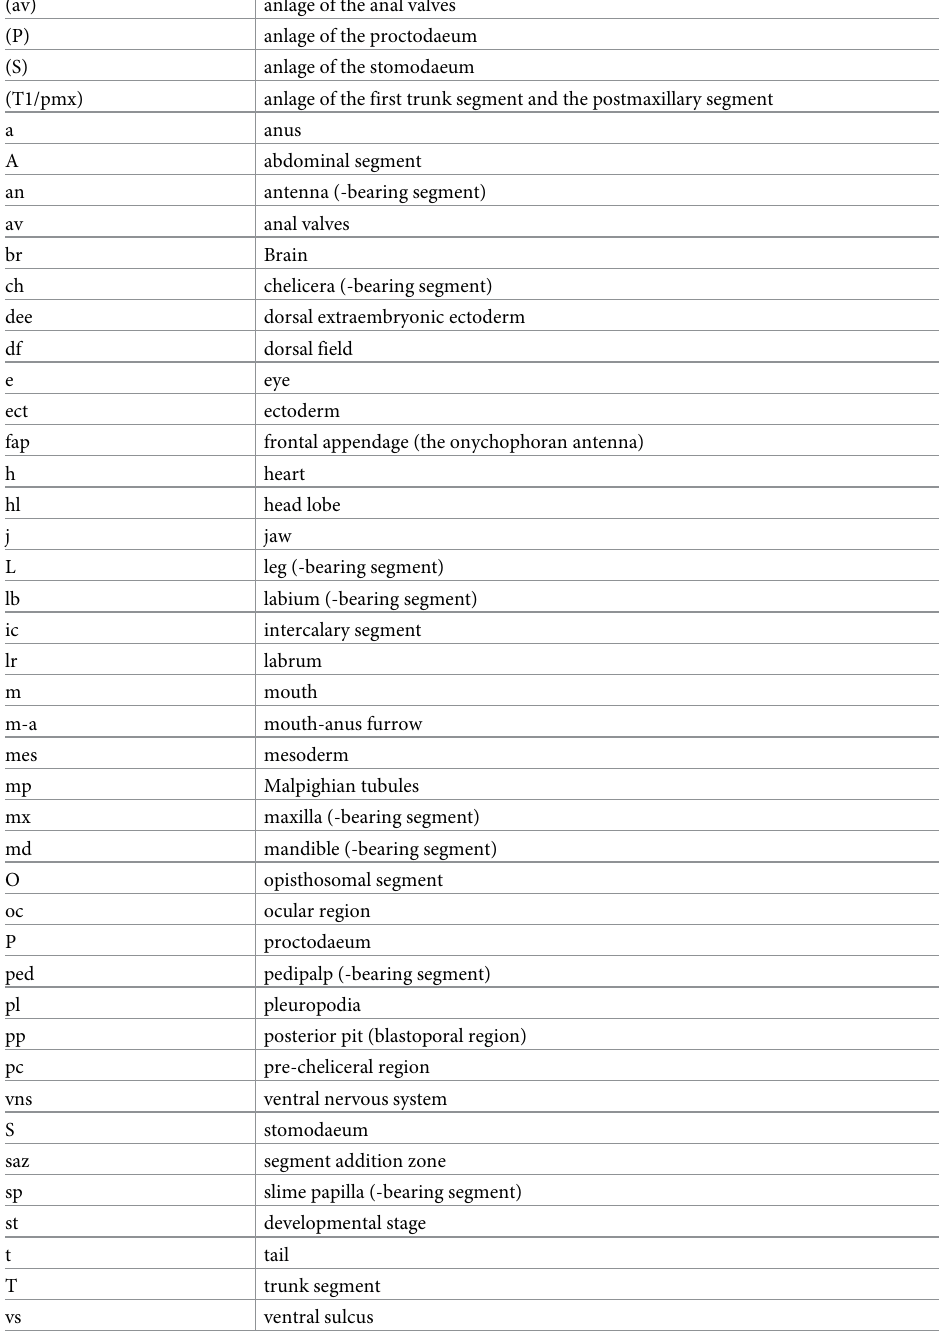
Table 2. Abbreviations.